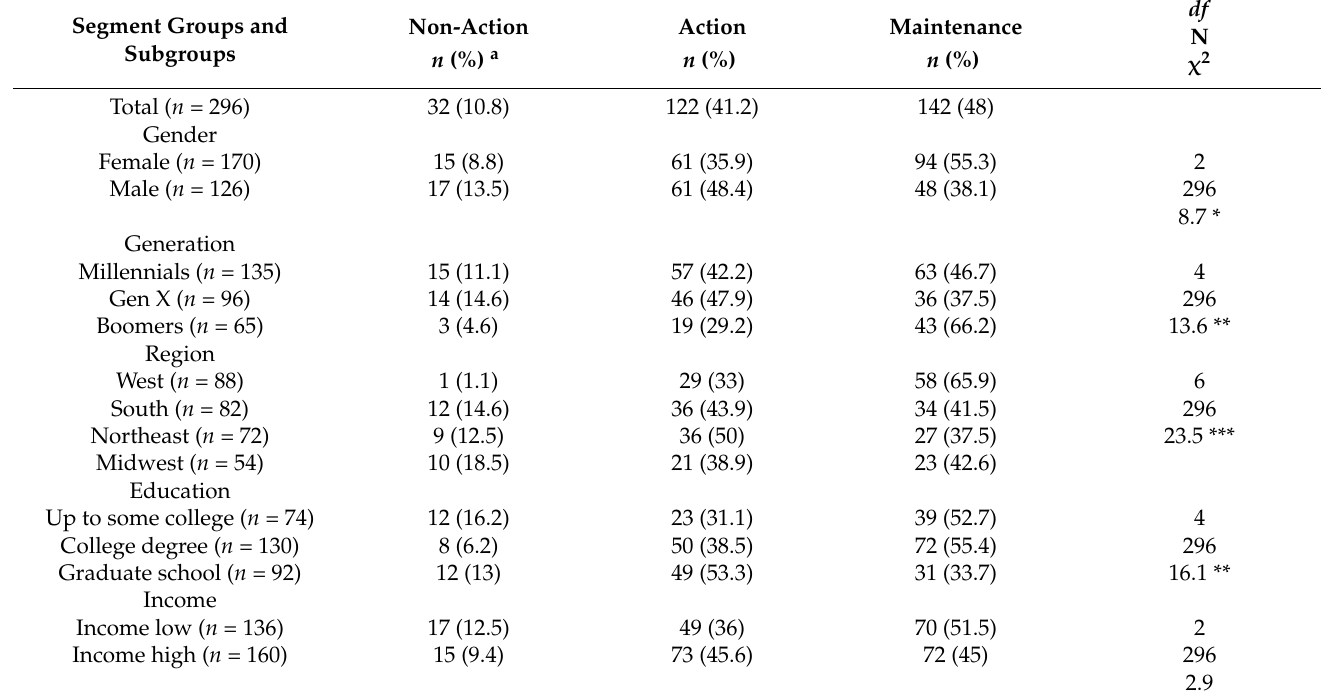
Table 2. Chi-square analysis for healthy eating stage-of-change of kombucha